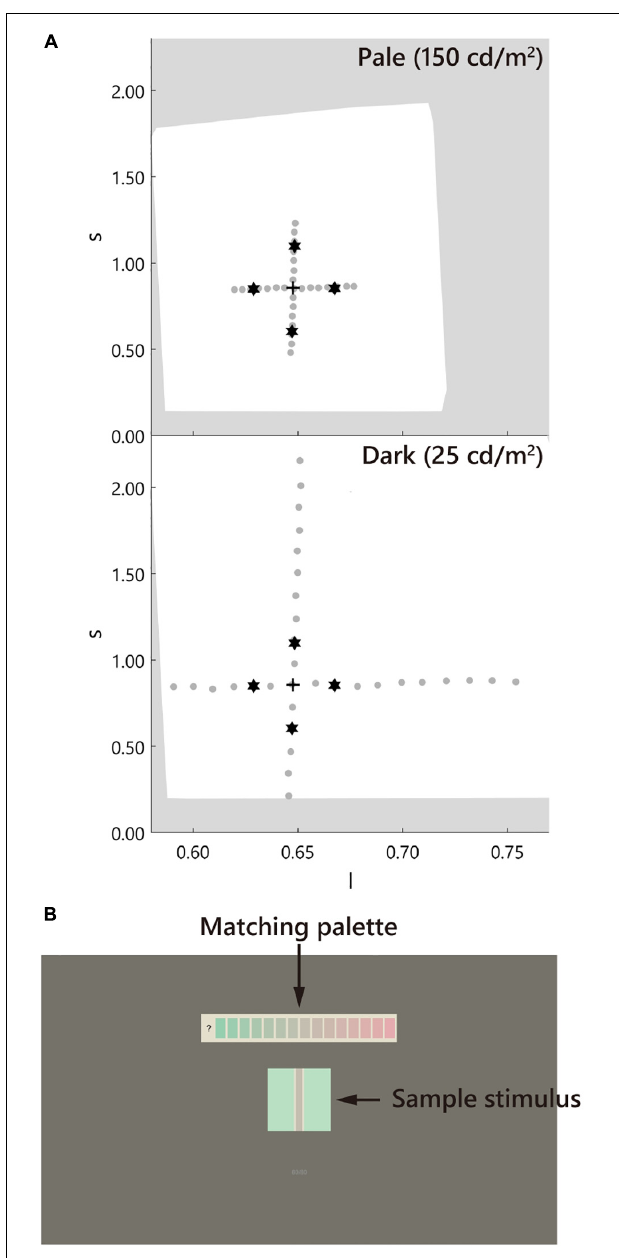
FIGURE 2 | Chromaticity of the stimuli and the screen design. (A) The stimulus was defined in the MacLeod–Boynton (MB) chromaticity space. The stars, cross, and gray dots indicate the inducer, D65 of the neutral gray, and the matching palettes, respectively. The white background indicates the gamut of the monitor. The upper and lower panels correspond to the pale (150 cd/m 2 ) and dark (25 cd/m 2 ) test line conditions, respectively. Note: the luminance of the inducer was maintained at 190 cd/m 2 . (B) The screen. The stimulus was placed at the center of the screen. The matching palette was placed above the stimulus.